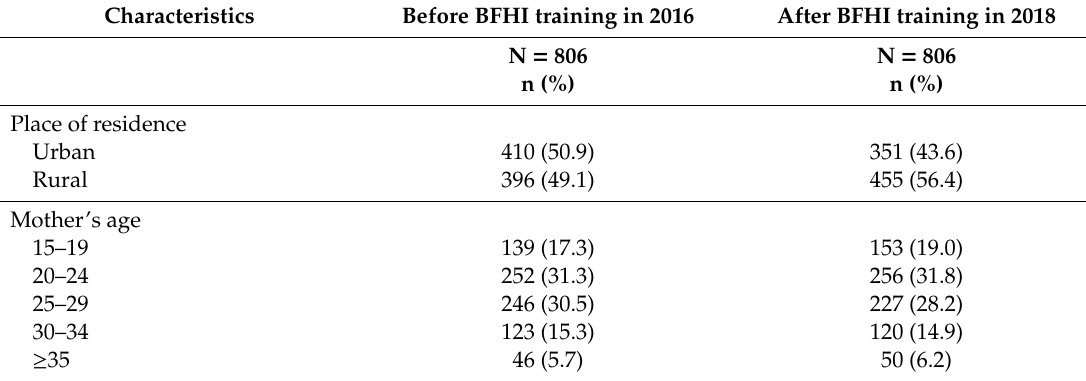
Table 1. Sociodemographic characteristics of mother–infant pairs before and after the Baby-Friendly Hospital Initiative (BFHI) training in Juba Teaching Hospital, South